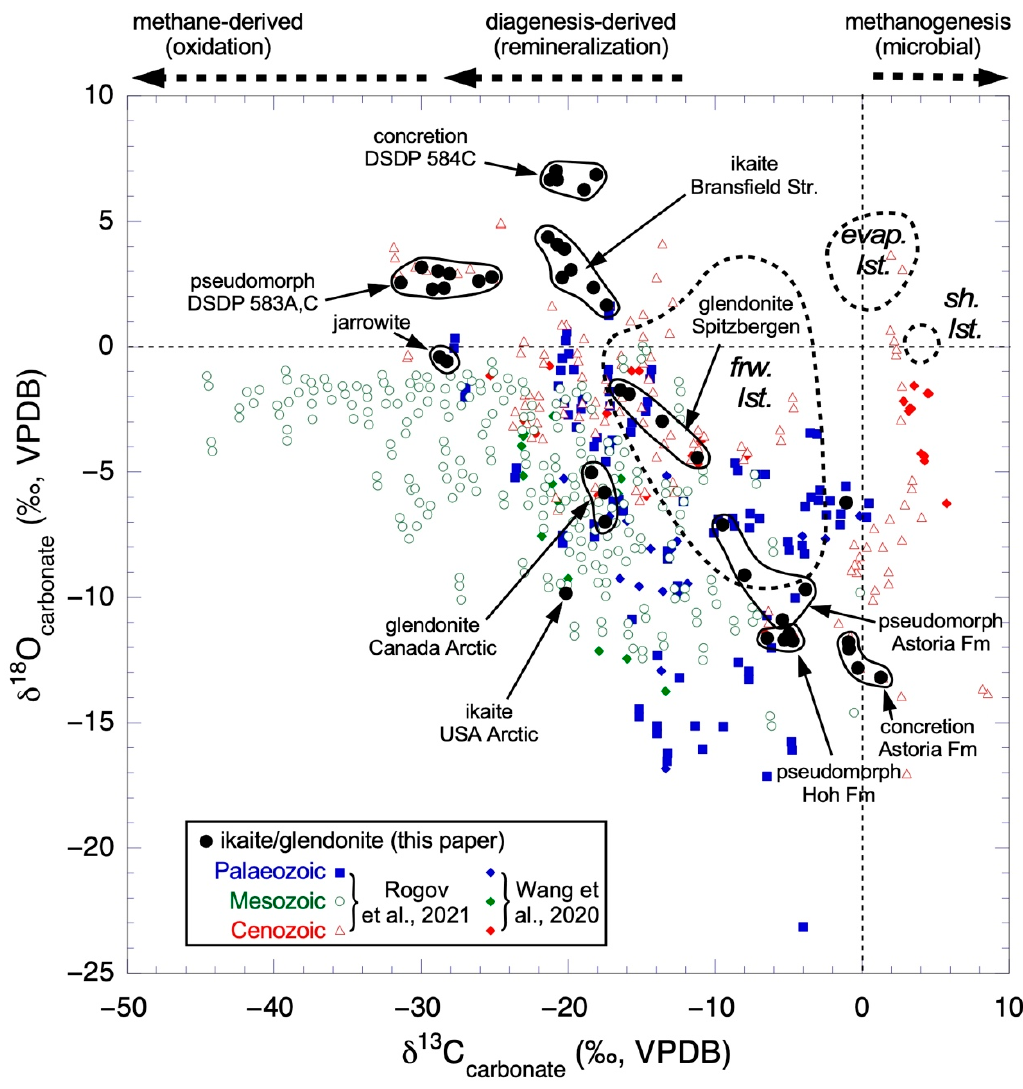
Figure 10. Plot of δ 18 O carbonate vs. δ 13 C carbonate for ikaite and glendonite samples reported in this paper. For reference the Phanerozoic (Paleozoic, Mesozoic, and Cenozoic) δ 18 O glendonite vs. δ 13 C glendonite databases of Rogov et al. (2021) [138] and Wang et al. (2020) [46] are shown. The wide range in isotope values largely reflects the differences in diagenetic settings and processes, rather than temperatures.